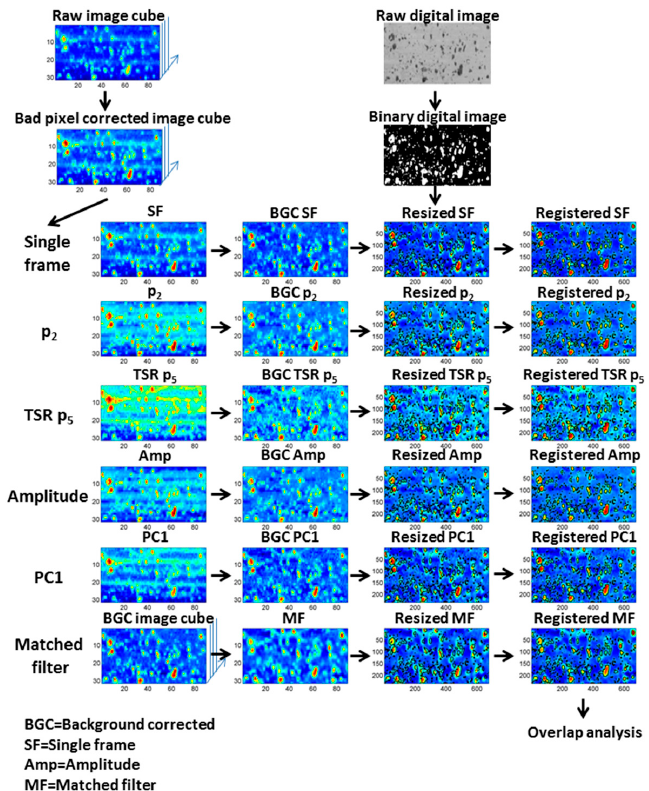
Figure 4. Overview of image processing steps. The input of all six thermal processing methods consists of a bad pixel corrected version of the raw thermal image sequences. The thermal output images of all methods are resized and registered to the digital reference images. Based on this, an overlap analysis and detection limit calculation is performed. The color scale of all images is normalized between zero and one to allow contrast comparison between the image processing algorithms. Coordinates are shown in pixels.